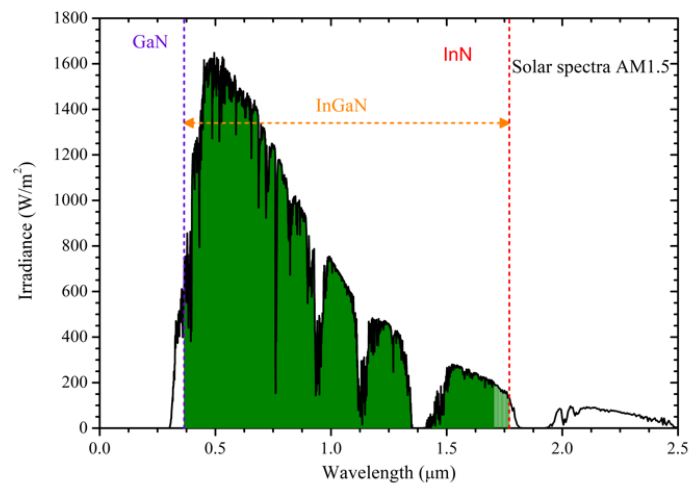
Figure 2. The AM1.5 solar spectra range absorbed by InGaN ternary alloy in the whole In content range. The photocurrent has been calculated using a model for the graded bandgap absorber layer [58]. Moreover, the absorption constant is calculated from the absorption coeffi- cient [59] and linearizing Equation (2) to average the constant absorption from different curves at different In content. Figure 3 presents the slopes (A) for the InGaN absorption coefficients with different In content in the alloy.